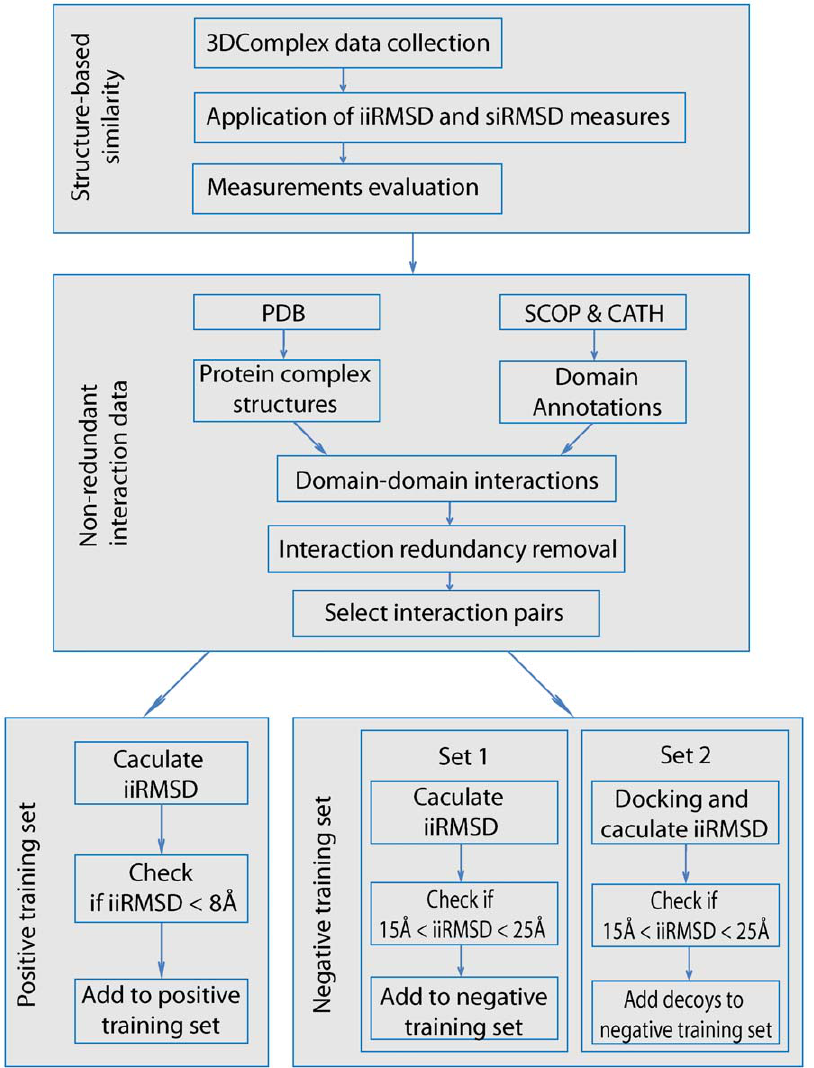
Figure 1. A protocol for obtaining a reliable set of similar and dissimilar interface pairs. First, two structure-based similarity measures, iiRMSD and siRMSD , are evaluated on a dataset collected from 3D Complex database. Second, a non-redundant domain-domain interaction data set is obtained from PDB, SCOP and CATH. Third, iiRMSD is used to classify positive (similar) and negative (dissimilar) training sets of pairs of interaction interface